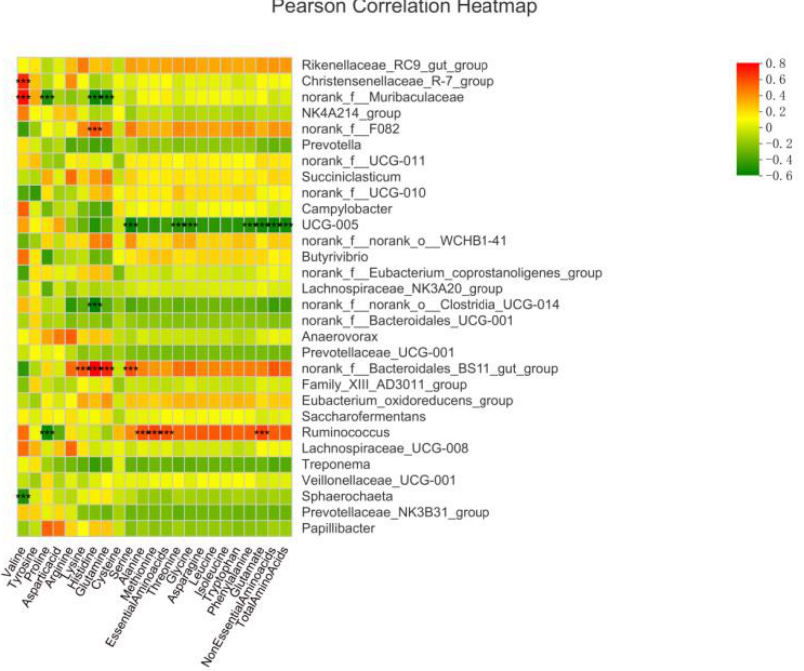
Figure 8. Correlation of bacterial genera with ruminal amino acid contents. In the two-dimensional heat map, the change in defined color and its depth indicates the nature and strength of the correlation, respectively. Asterisk sign was used when the r value was greater than 0.1 and the p values were less than 0.05 (* 0.01 < p ≤ 0.05, ** 0.001 < p ≤ 0.01, *** p ≤ 0.001).